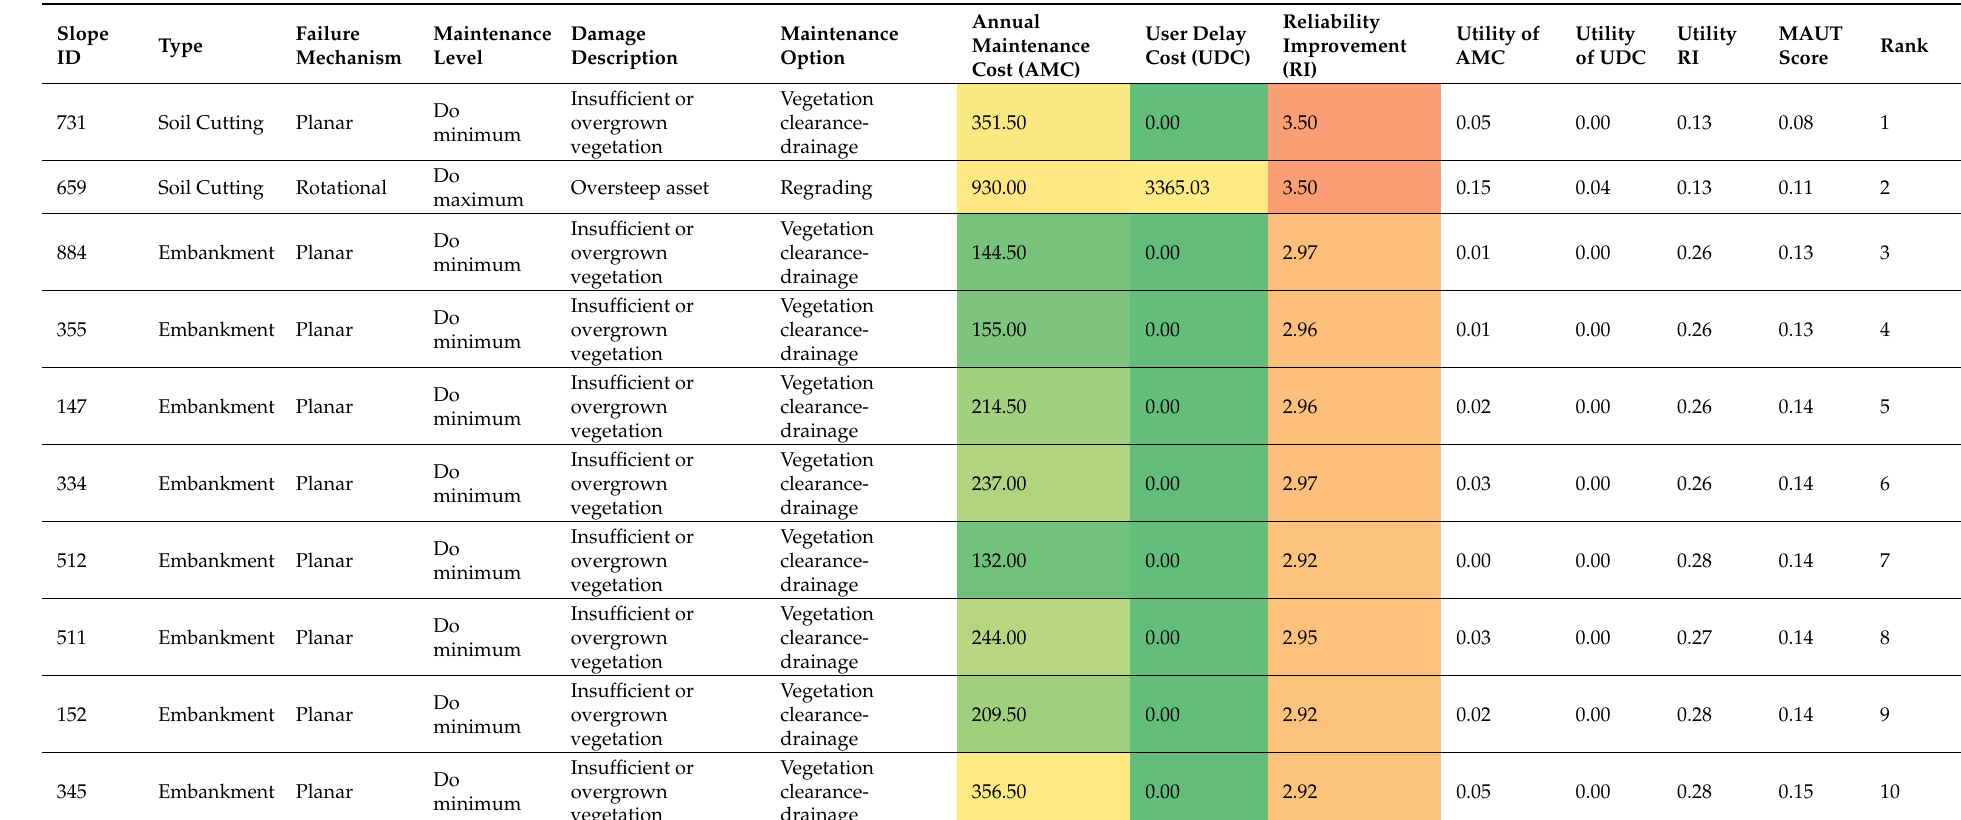
Table 4. Highest ranked slopes using